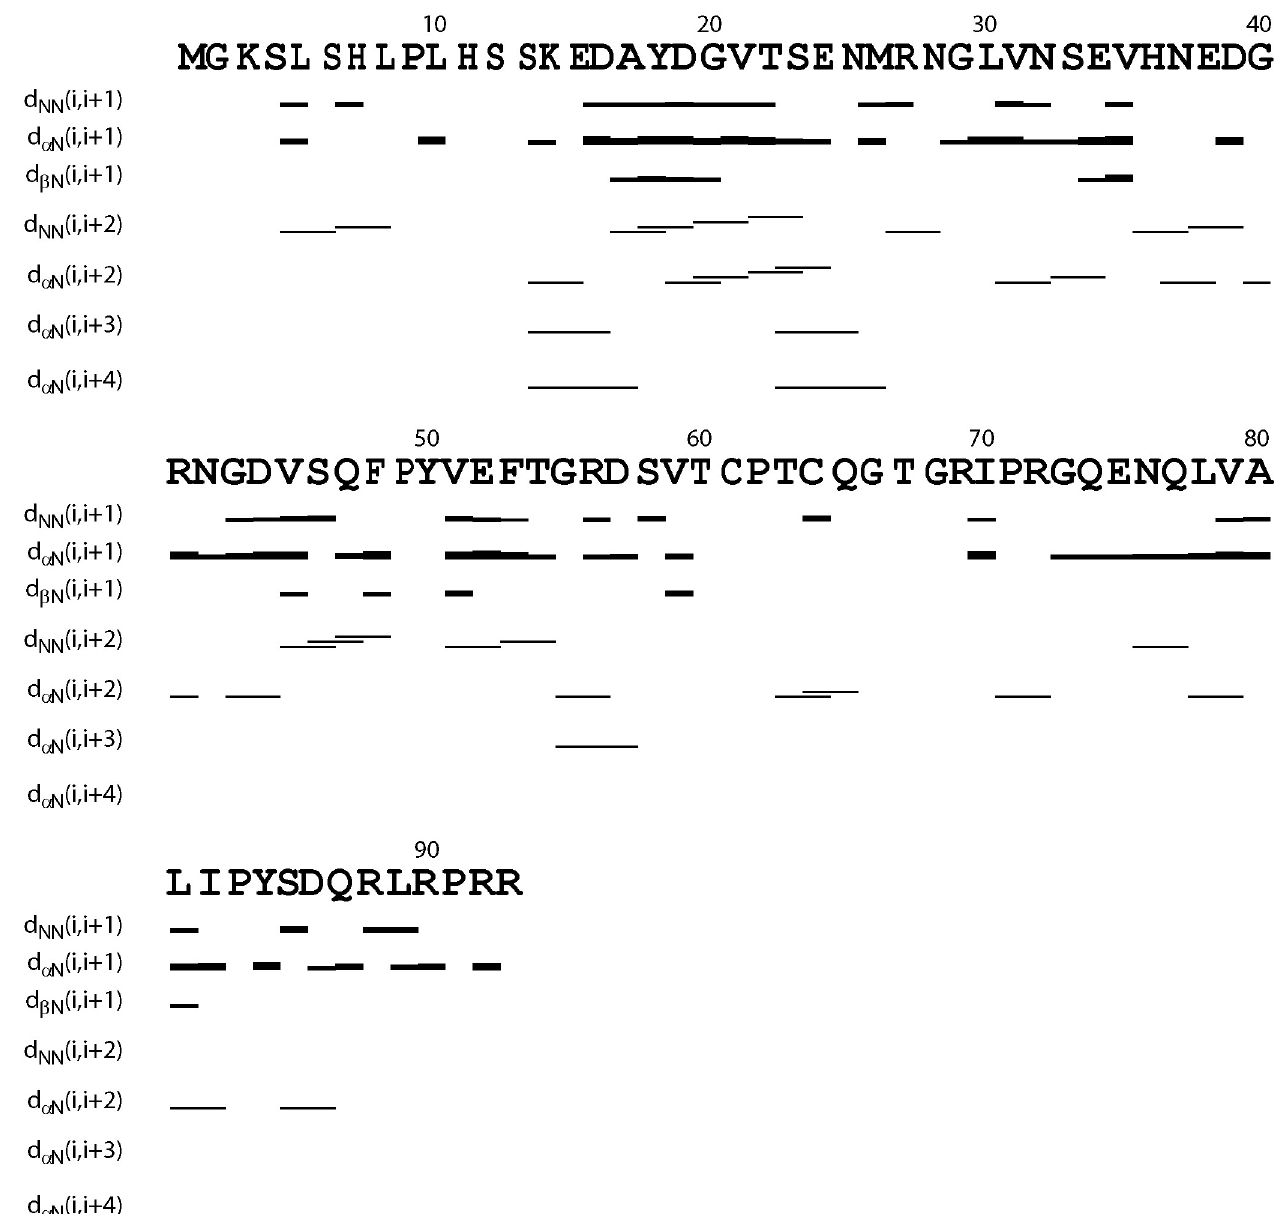
Fig 4. Characteristic NOE connectivities defining secondary structures of the TMEM106B cytoplasmic domain.